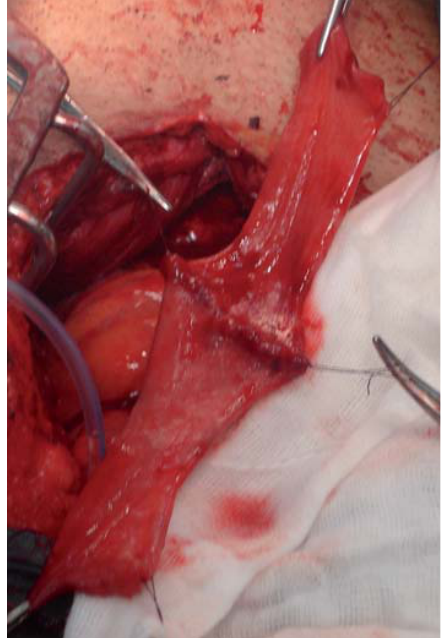
Figure 2 - Unfolding of the incised ileal segments with sutu- ring of their adjacent